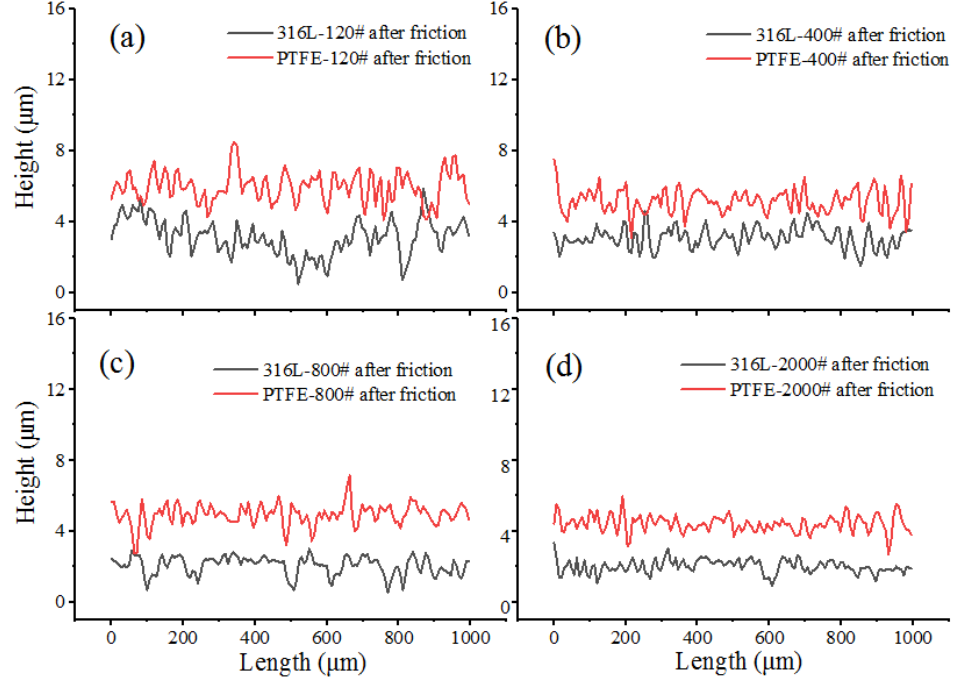
Figure 13. The profile curves of 316L sample and PTFE sample after friction experiments under lubrication pressure of 8 MPa: ( a ) the 316L sample polished by 120# abrasive paper; ( b ) the 316L sample polished by 400# abrasive paper; ( c ) the 316L sample polished by 800# abrasive paper; ( d ) the 316L sample polished by 2000# abrasive paper.